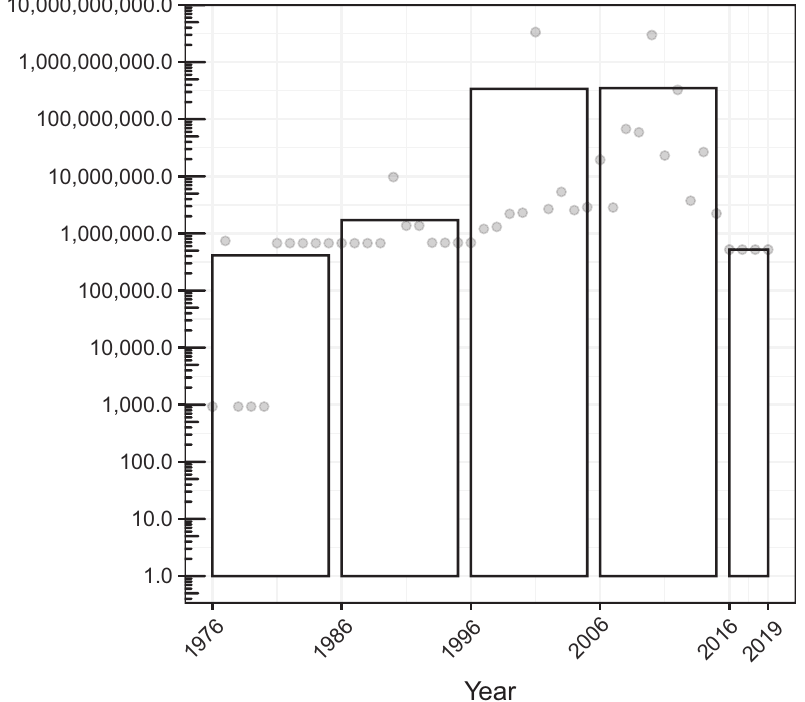
Figure 5. Annual average costs of biological invasions in the United Kingdom, considering decadal means (except 2016 to 2019: four years mean). Grey points indicate annual total costs. Note the y -axis is on a log 10